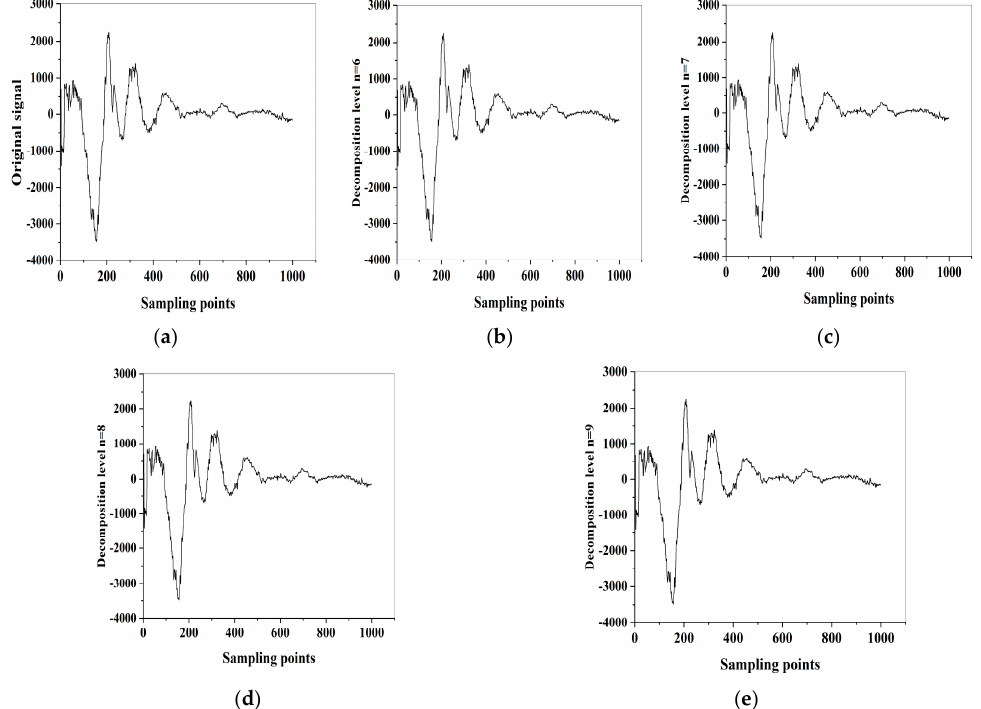
Figure 10. Denoised signals with different decomposition levels. ( a ) 5 levels; ( b ) 6 levels; ( c ) 7 levels; ( d ) 8 levels; ( e ) 9 levels.